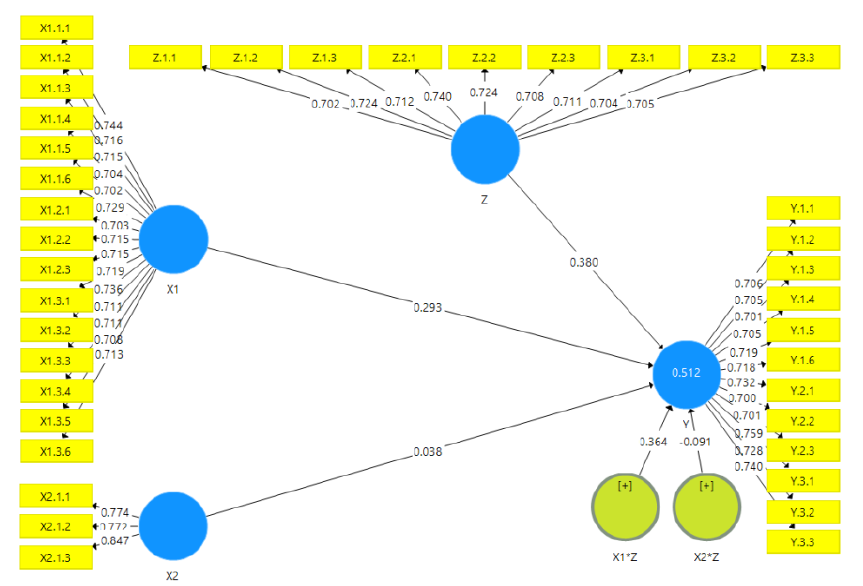
Figure 3: Research Structural